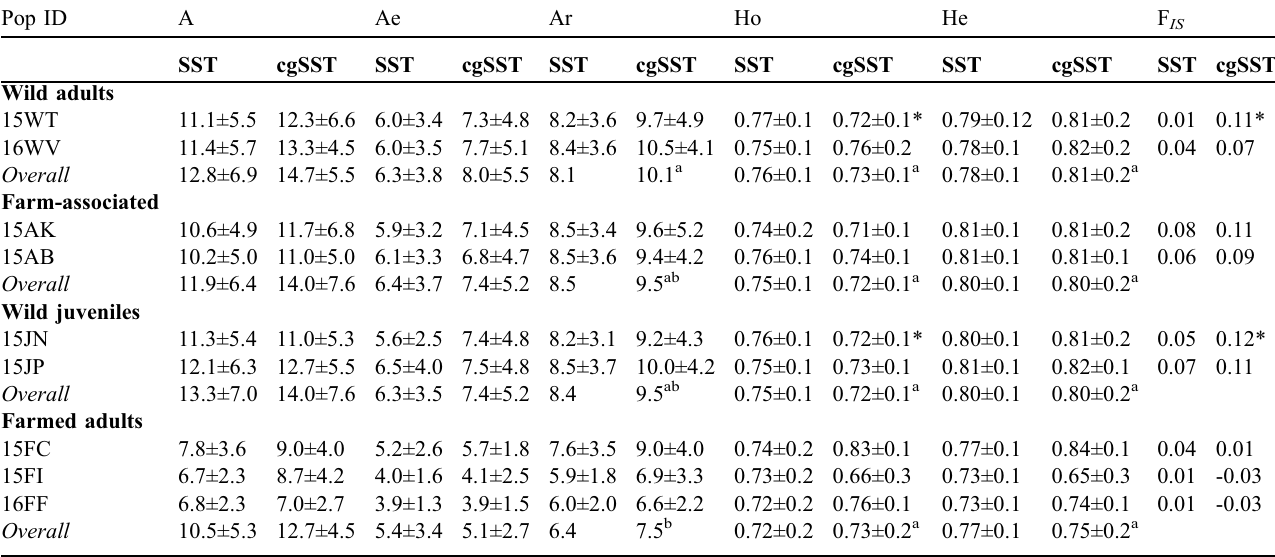
Asterisks indicate statistical signi fi cance in treatment groups (* p < 0.01) while different superscript letters indicate signi fi cant deference between groups for each